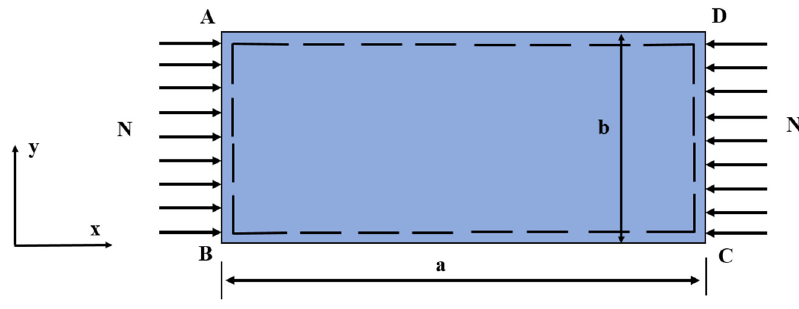
Figure 2. Loading and geometry of the thin-plate buckling problem.